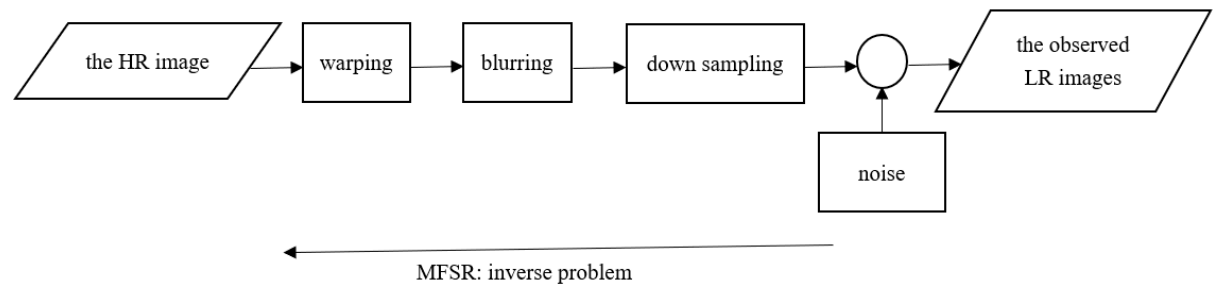
Figure 2. The observation model of MFSR.